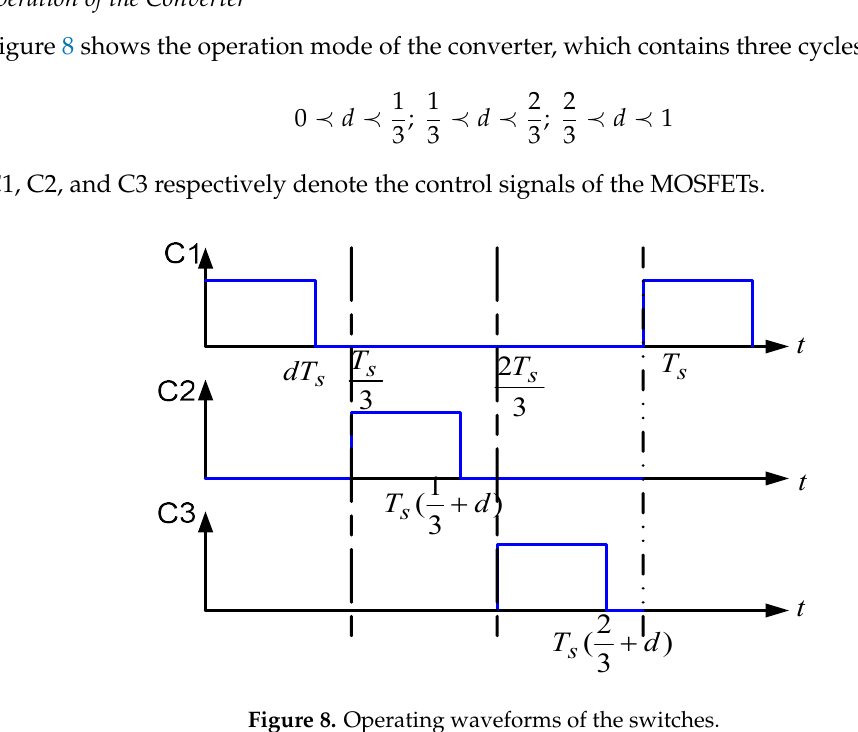
Figure 7. Topology of the converter.